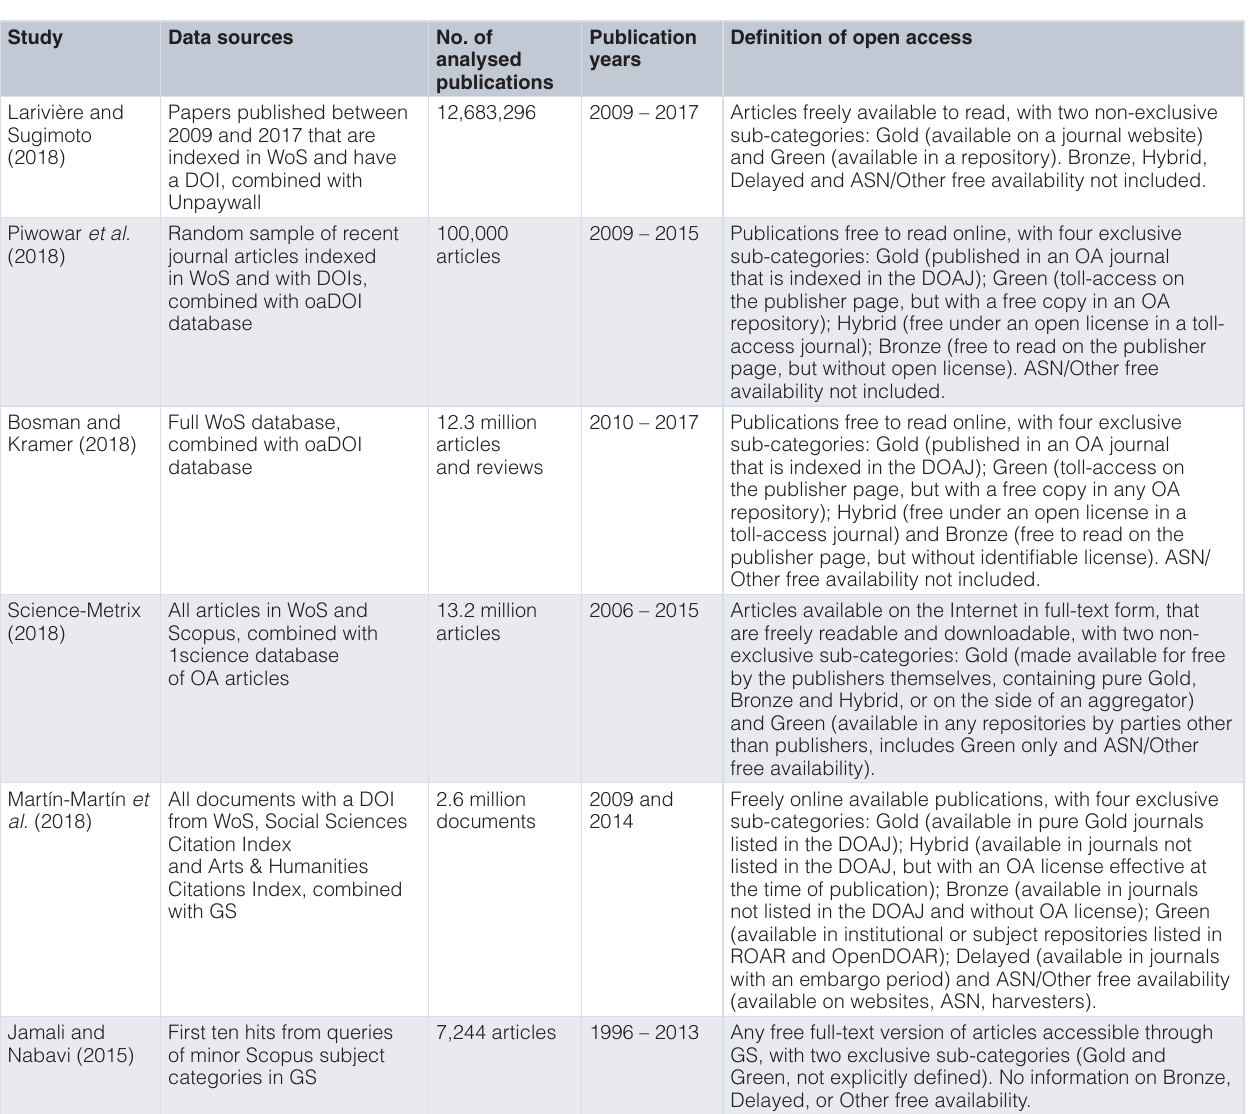
Table 3. Studies included in the meta-synthesis: Methodological approaches.